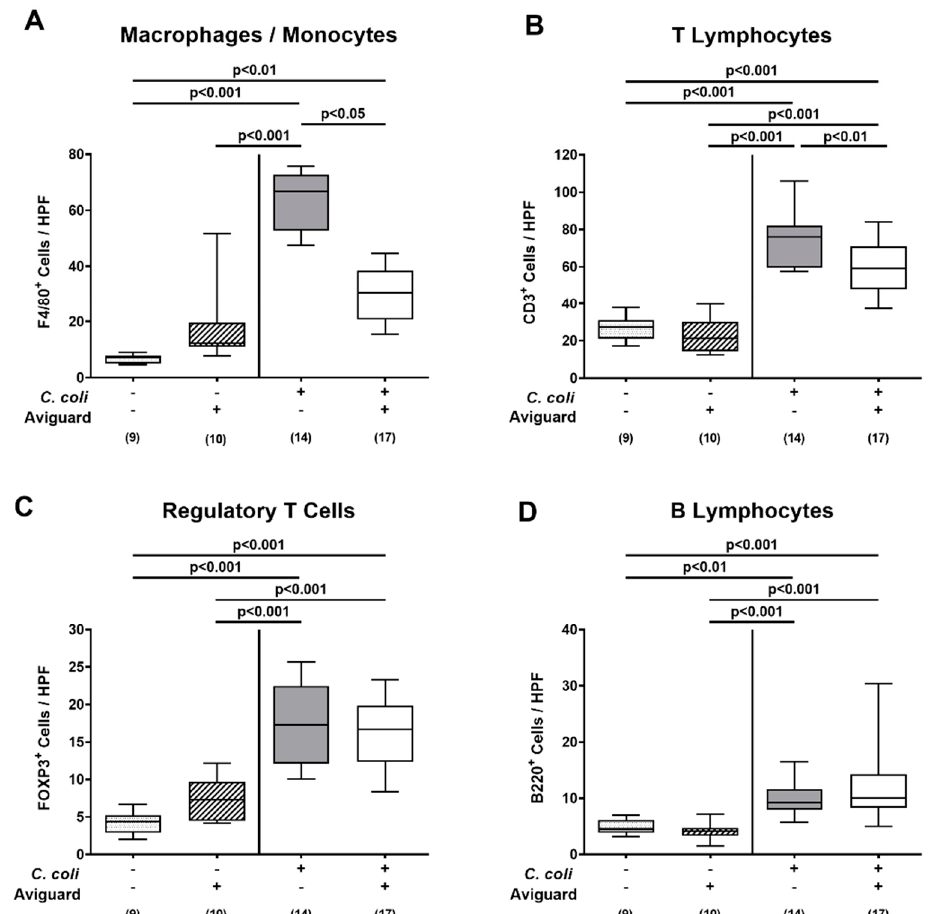
Figure 5. Colonic immune cell responses following peroral Aviguard ® treatment of C. coli -infected secondary abiotic IL- 10 − / − mice. Mice were infected with a C. coli patient isolate on day (d) 0 and d1 by gavage. On d2, d3 and d4 post-infection (p.i.), mice were perorally challenged with the probiotic formulation Aviguard ® (white boxes) or received placebo (gray boxes). On d6 p.i., the average numbers of ( A ) macrophages and monocytes (F4/80 + ), ( B ) T lymphocytes (CD3 + ), ( C ) regulatory T cells (FOXP3 + ) and ( D ) B lymphocytes (B220 + ) were determined microscopically from six high-power fields (HPF, 400 × magnification) per animal in immunohistochemically stained colonic paraffin sections. The box plots